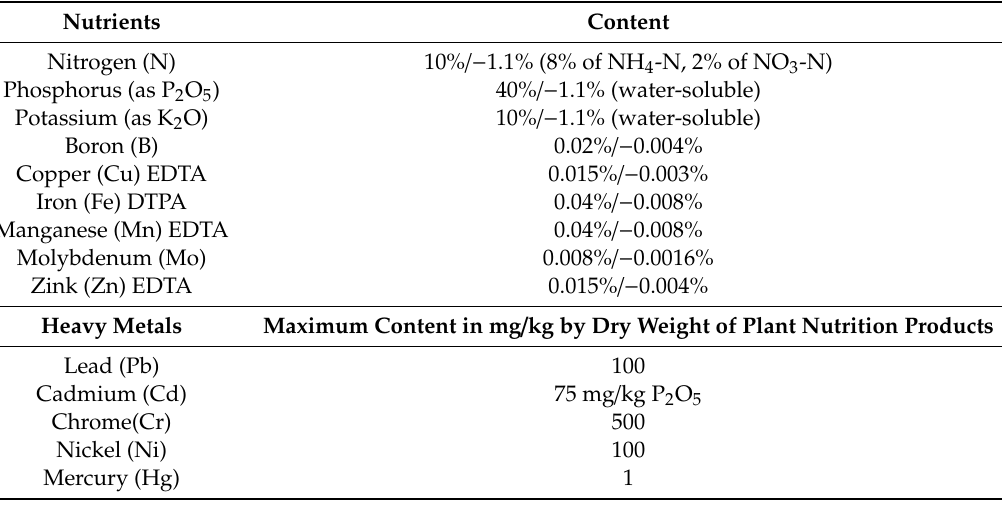
Table 2. The chemical composition of the applied Starter-A